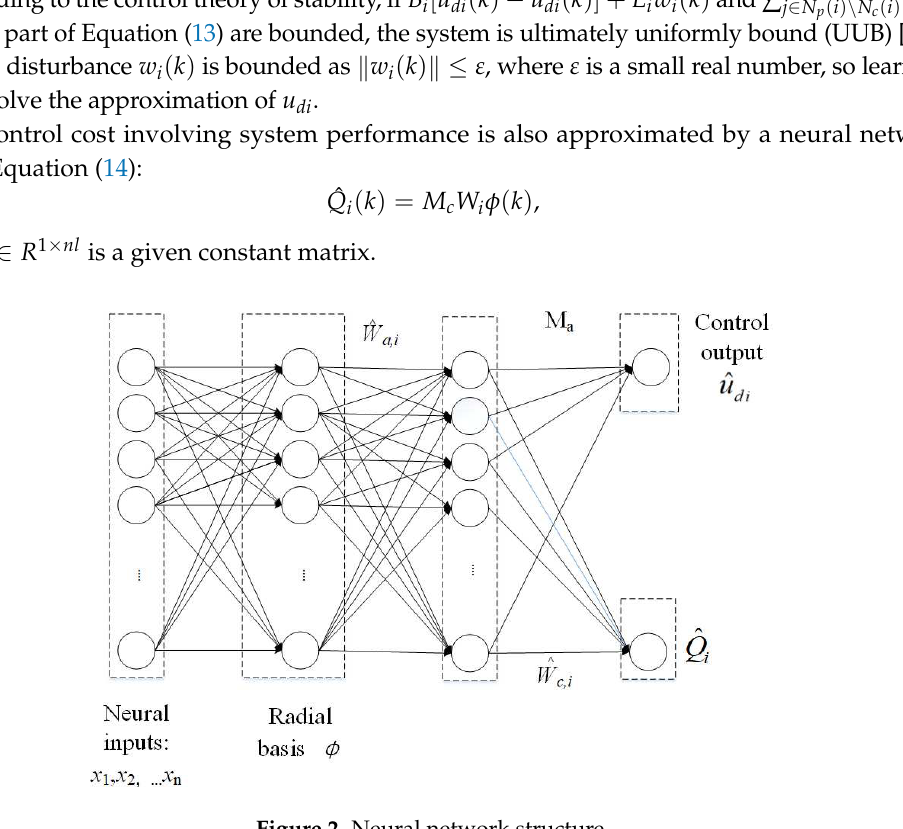
Figure 2. Neural network